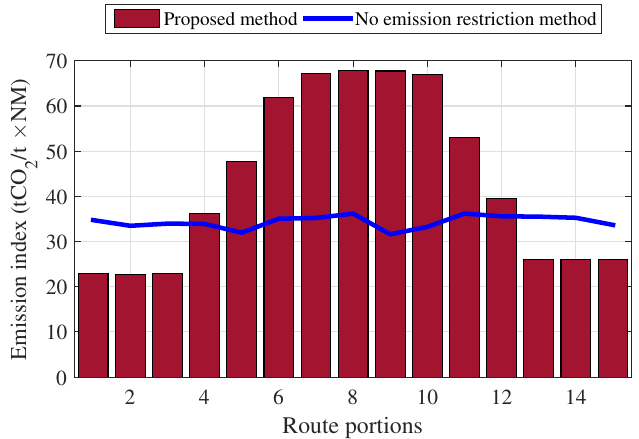
Figure 11. Emission index values at different route